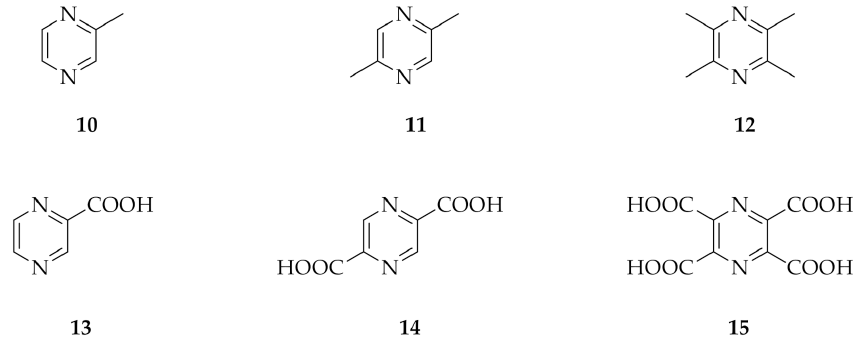
Figure 3. Chemical structures of the different pyrazines